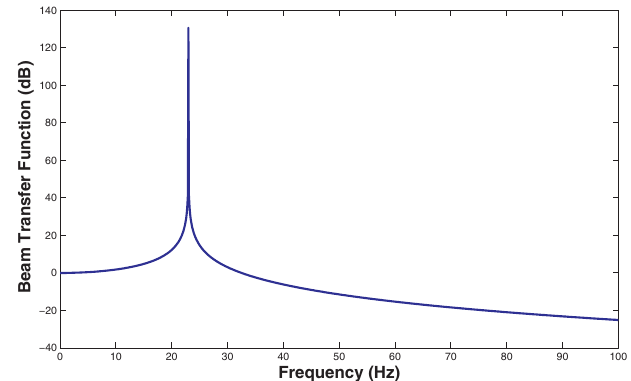
FIG. 3. (Color) Beam transfer function during physics defined (cid:2) T . As expected, the resonance is at by ½ 1 0 (cid:2)ð 2 (cid:10)ifI (cid:3) A Þ (cid:3) 1 ½ 0 ! 2 s the synchrotron frequency of about 22 Hz for the physics configuration. The resonance is even sharper during injection due to the longer synchrotron radiation damping